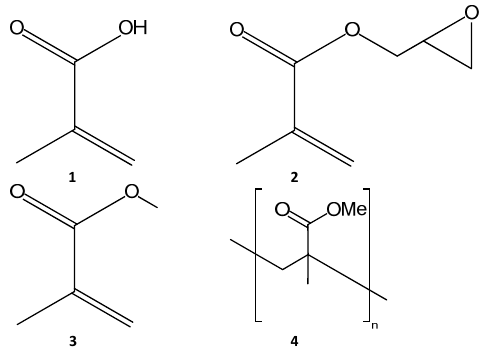
Figure 1. Chemical structures of ( 1 ) methacrylic acid; ( 2 ) glycidyl methacrylate; ( 3 ) methyl methacrylate; and ( 4 ) PMMA.